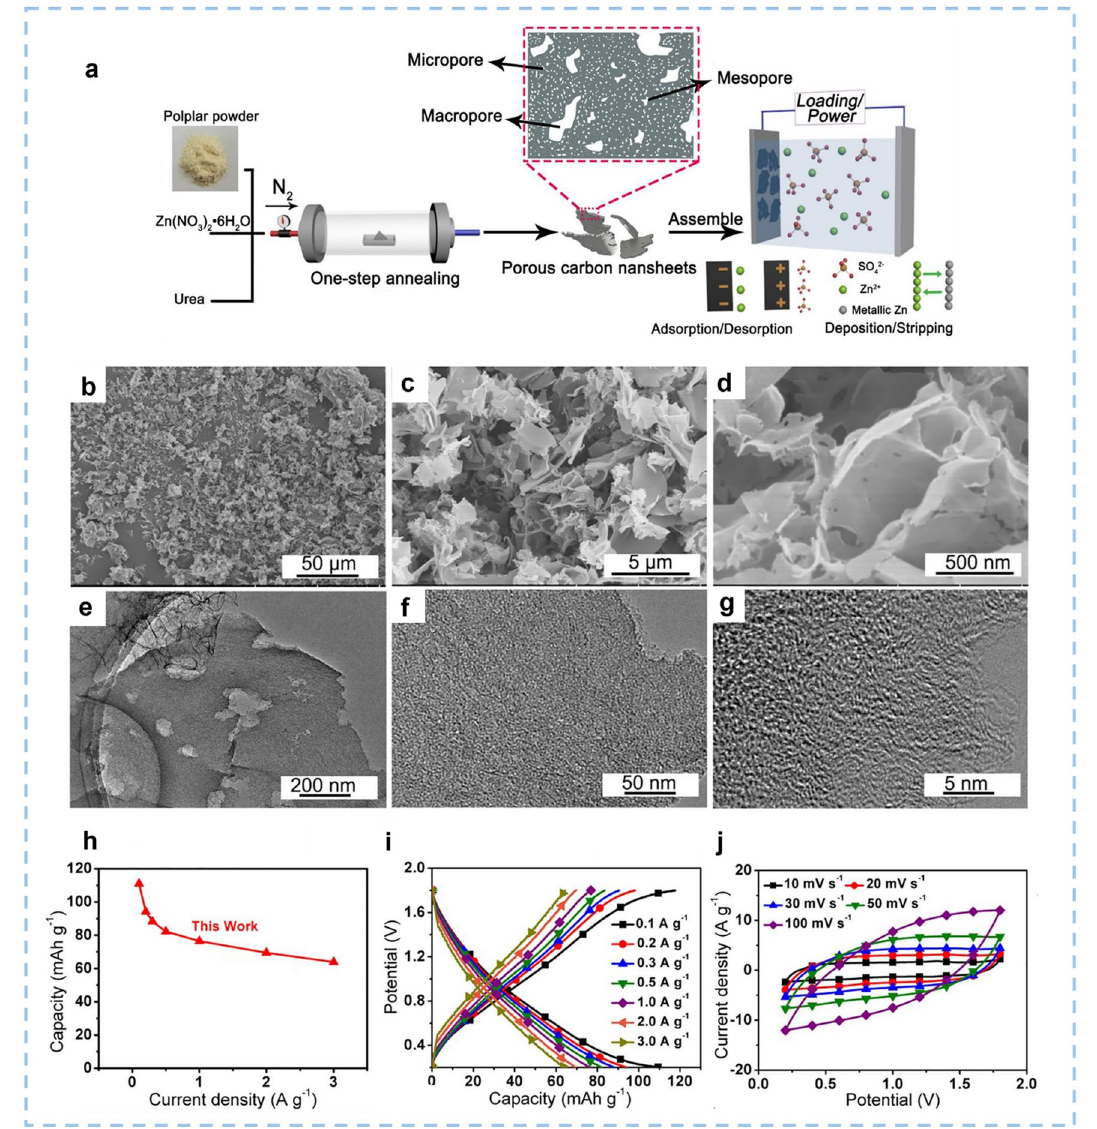
Fig. 9 The synthesis procedure, morphology and structure of the WC-6ZnN-12U, and the electrochemical performance of the aqueous WC- 6ZnN-12U//Zn system. a Schematic illustration for the synthesis of carbon nanosheets of WC-6ZnN-12U. b‑d SEM images and e–g TEM images of the WC-6ZnN-12U. h Specific capacity of WC-6ZnN-12U based ZIHC. i GCD and j CV curves of the ZIHC based on WC-6ZnN- 12U. Reproduced with permission [154]. Copyright 2021,